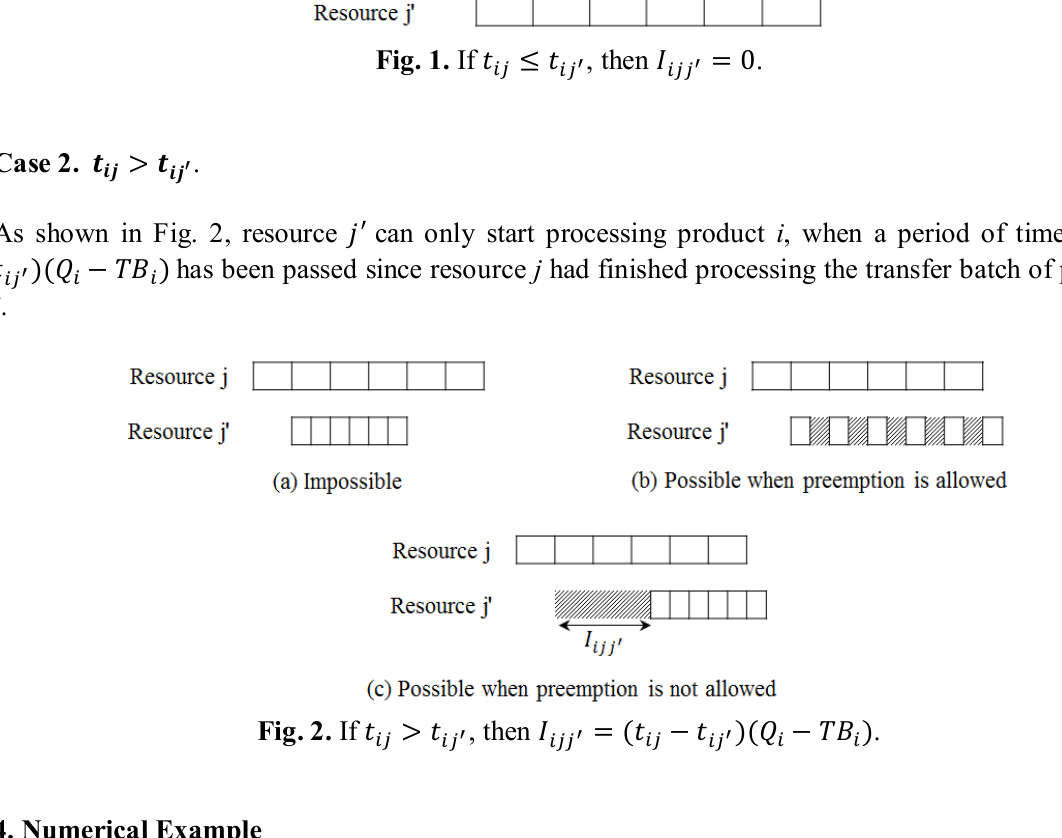
= 0 . (cid:3036)(cid:3037)(cid:3037) (cid:4594)